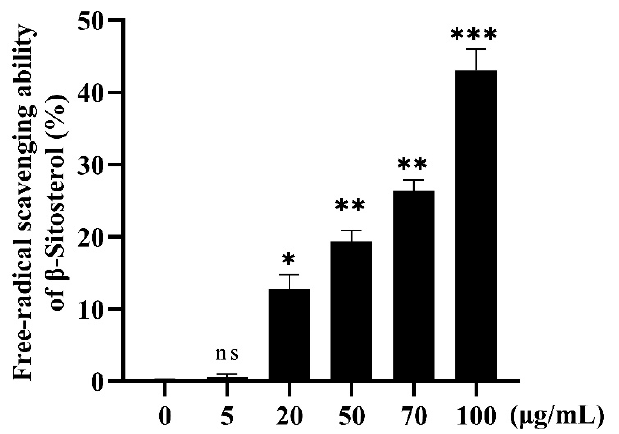
Figure 2. Free radical scavenging rates of β -sitosterol at different concentrations. Each bar represents the mean ± standard error for three different experiments performed in triplicate. ns, no statistical significance, * p < 0.05, ** p < 0.01, and *** p < 0.001 compared with the control group (0 μ g/mL β - sitosterol).